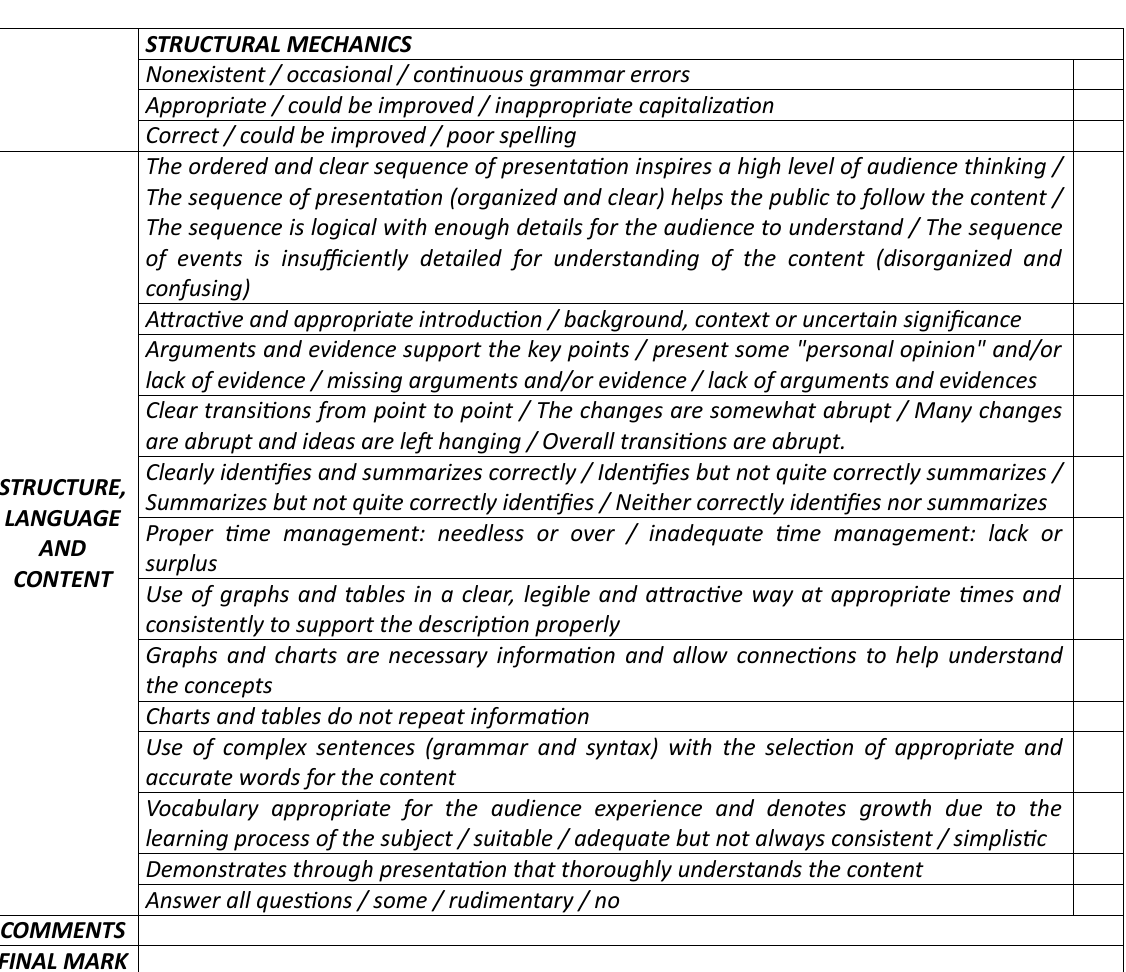
Table 1. Learning and assessing student oral communicaton skills